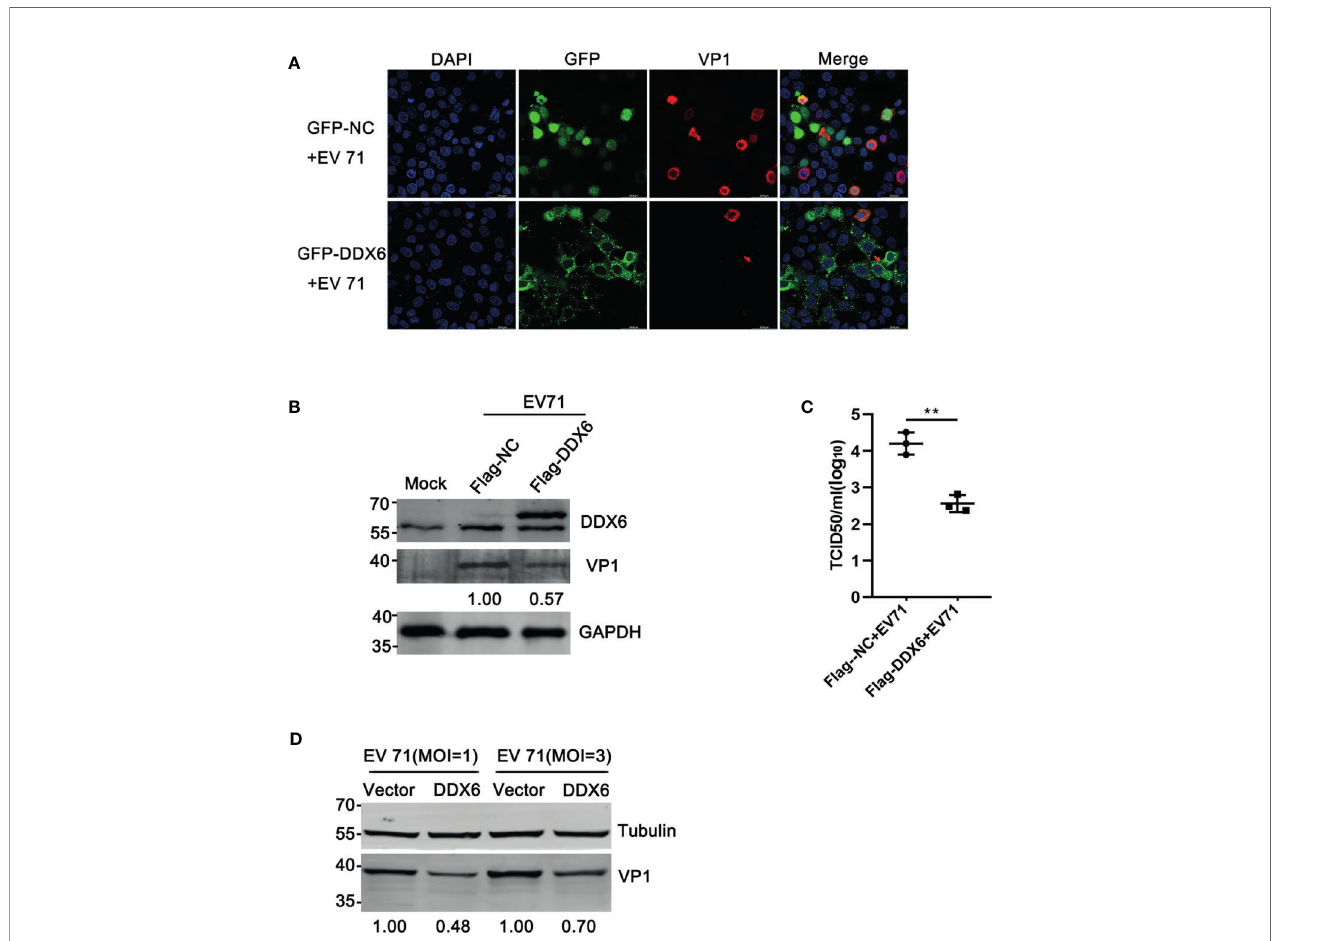
FIGURE 3 | DDX6 conferred cellular resistance to EV71 infection. (A) The plasmids expressing GFP-NC or GFP-DDX6 were expressed in HeLa cells, and the cells were infected with EV71 (MOI=2) for 24 h. The infected HeLa were fi xed and stained by staining with anti-VP1 antibody (red), and the cell nuclei stained with DAPI (blue). The images were taken with an Olympus FV3000 confocal microscope, scale bar: 50 µm. (B) HeLa cells were transfected with a plasmid expressing DDX6 (pcDNA3.1-Flag-DDX6) or a control plasmid (pcDNA3.1-Flag). After 24 h of transfection, the cells were treated with EV71 (MOI=2). At 24 hpi, the cell lysates were analyzed by western blot using antibodies speci fi c for DDX6, VP1, and GAPDH. The value for lane 2 was 1.00. (C) The amount of progeny virus in the supernatant from treated cells was determined through a standard plaque assay. The values represented three independent experiments ( n = 3, ** P < 0.01). The error bar represented mean with SD. (D) The relative VP1 expression in vector or DDX6 over-expressed cells infected with EV71 (MOI = 1 or 3) was determined by Western